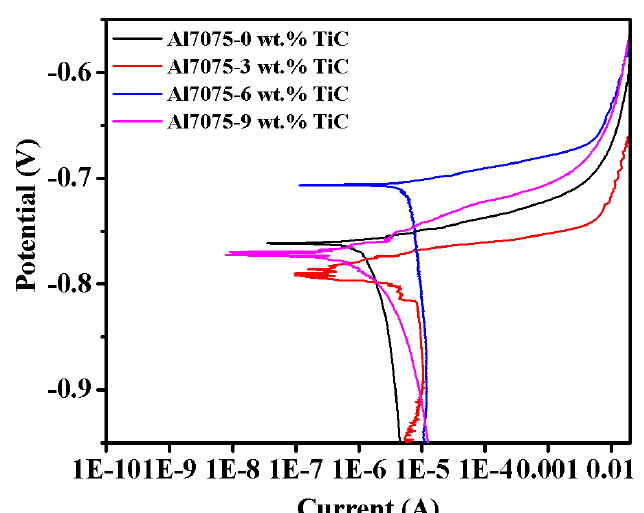
Fig. 16. Tafel plots of Al 7075 and Al 7075 –TiC composites tested in3.5 wt.% NaCl.